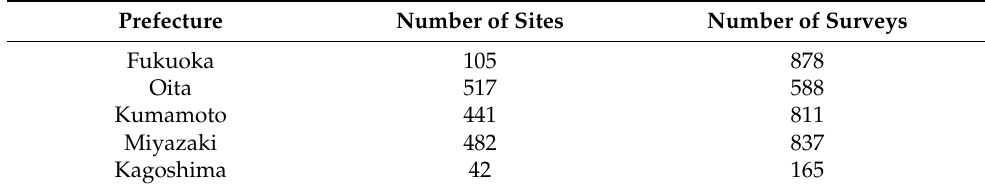
Figure 1. All survey sites from 1995 to 2019 ( left ) and the location of surveyed prefectures ( right ). Fu, Oi, Ku, Mi, and Ka indicate the Fukuoka, Oita, Kumamoto, Miyazaki, and Kagoshima prefectures, respectively. ECS and SIS indicate East China and the Seto Inland Seas, respectively. PAC is the Pacific Ocean. Table 1. Number of sites and surveys of the fecal pellet count in each prefecture.